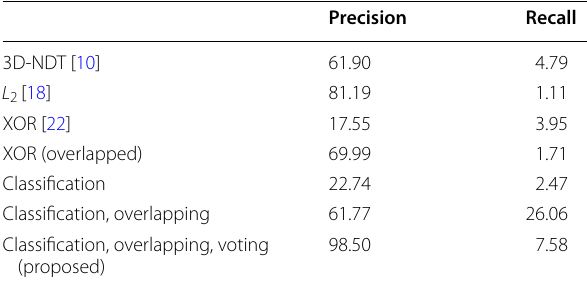
Table 4 Precision and recall [%]